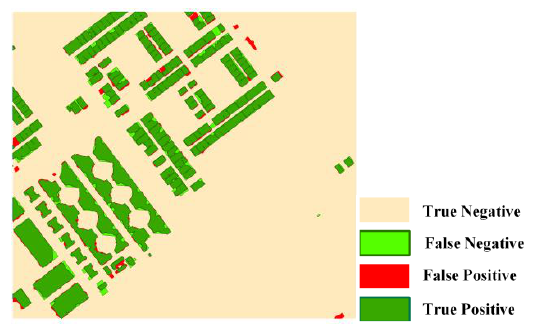
Figure 19. Accuracy estimation